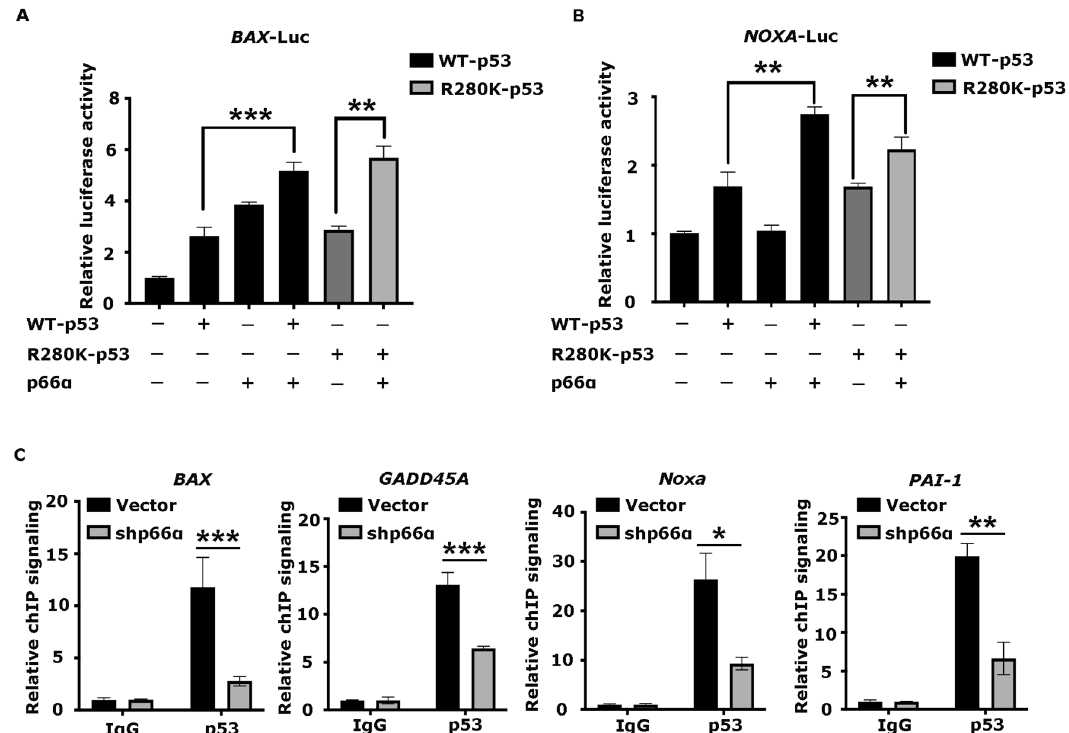
Figure 5. p66 α promotes the transactivity of p53 by enhancing p53 binding at target promoters ( A ) Luciferase assays were performed in HEK-293T cells knocking down of p53. The value was normalized to β -gal. Both p53WT and p53R280K synergistically worked with p66 α to transactivate the BAX promoter. ( B ) Luciferase assays showed that both p53WT and p53R280K synergistically worked with p66 α to transactivate the NOXA promoter. ( C ) ChIP assays were performed in MDA-MB-231-shp66 α and shVector cells using an antibody specific to p53. The enriched DNA fragments were amplified by qRT-PCR assays. * p < 0.05, ** p < 0.01, *** p < 0.001. All data were shown as mean ± S.D. from three independent